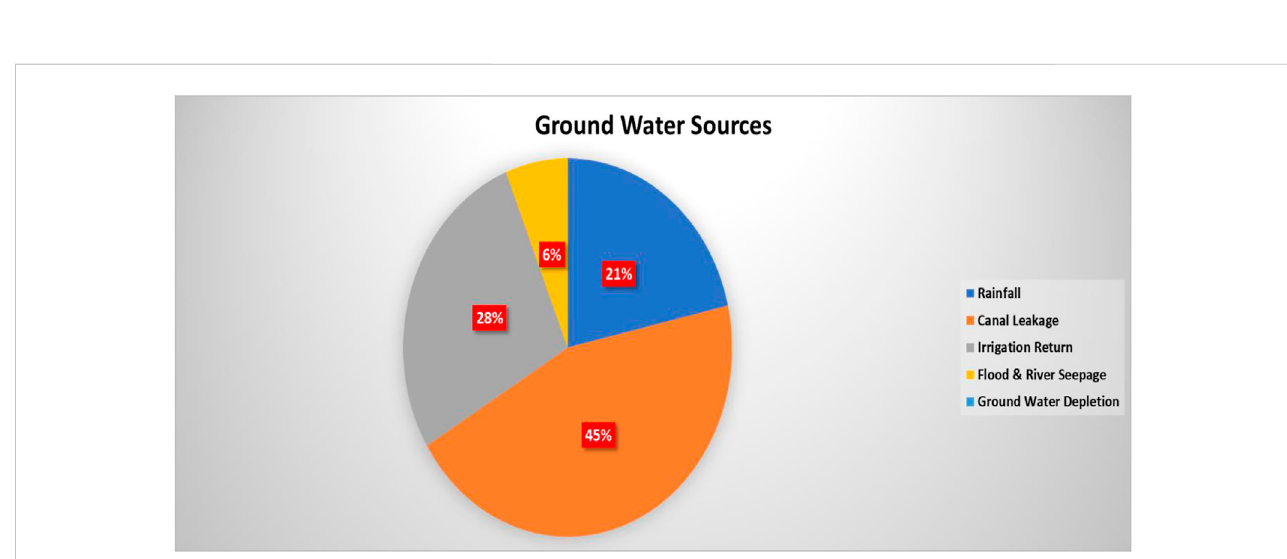
FIGURE 7 Groundwater sources in Pakistan (World Bank Report https://www.worldbank.org/en/news/feature/2021/03/25/managing-groundwater-resources-